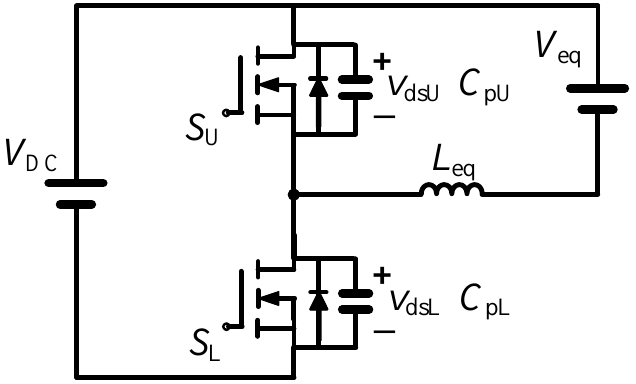
Figure 3. Unified equivalent circuit of the DAB converter, in which all the possible switching instances can be